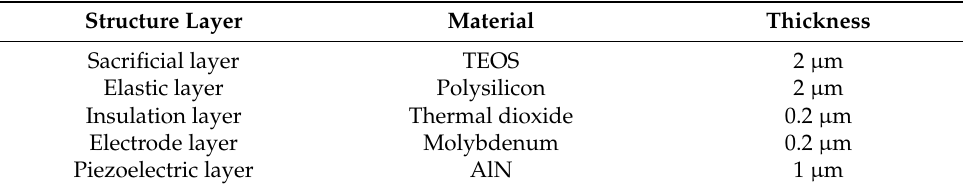
Figure 2. The relationship between the effective coupling coefficient and thickness of AlN film (red curve) and the relationship between the flexural rigidity and thickness of AlN film (blue curve). Table 1. Material and thickness for each layer of our PMUT structure.